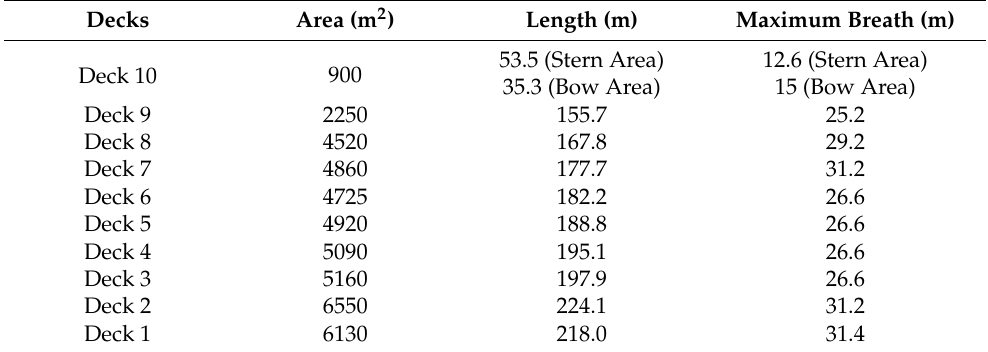
Figure A13. The space model of decks. ( a ) Deck 10; ( b ) Deck 9; ( c ) Deck 8; ( d ) Deck 7; ( e ) Deck 6; ( f ) Deck 5; ( g ) Deck 4; ( h ) Deck 3; ( i ) Deck 2; ( j ) Deck 1. Table A2. The dimensions and areas of the decks.